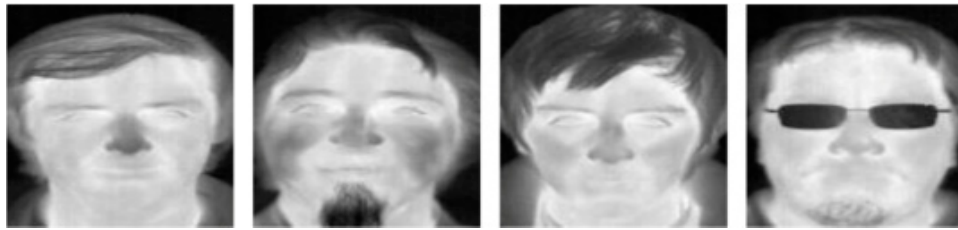
Figure 1. Example images of face recognition in thermal images.